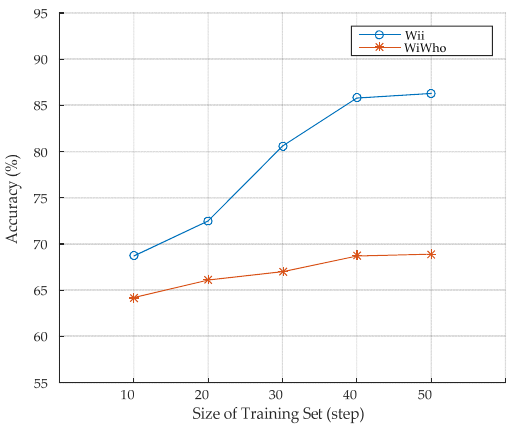
Figure 8. Step segmentation. Figure 8. Step